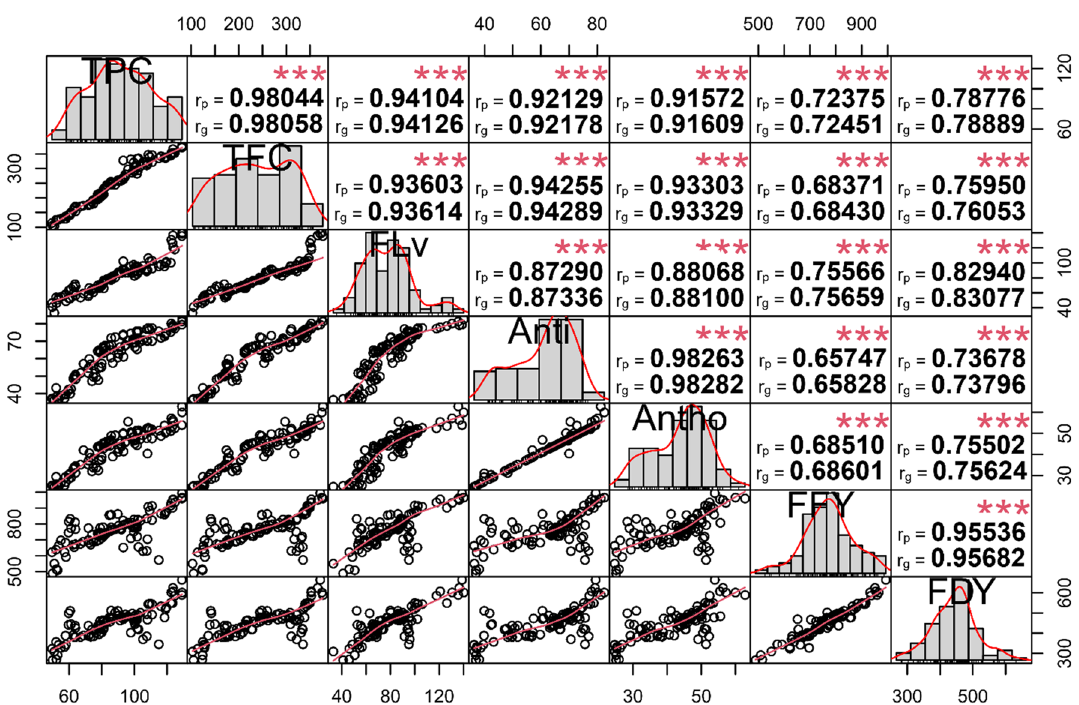
Figure 4. Phenotypic (rp) and genotypic (rg) correlation coefficients for traits in 100 of Poa pratensis accessions evaluated in drought stress